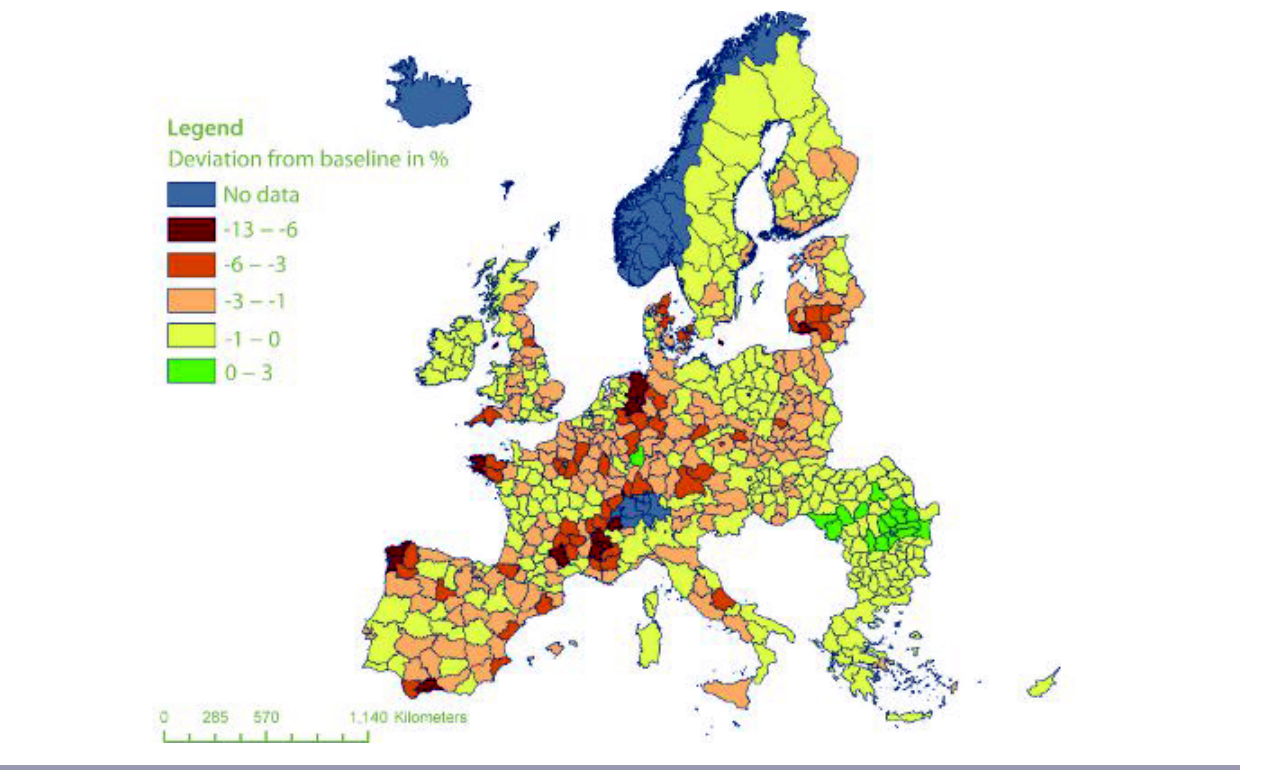
Fig. 3 . Common Agricultural Policy financial reform scenario: 100% cut of Common Agricultural Policy first pillar measures (market support and direct income support), and re-investment of savings in research and development. The map outlines the impacts on the area covered by arable land in terms of absolute changes of the area share of arable land compared to the baseline on NUTS-X level in